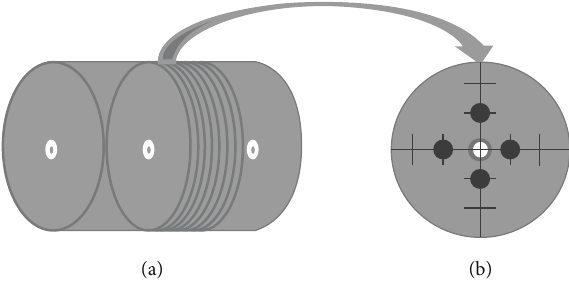
Figure 1: Stick drawing demonstrating the section process of histological examinations: (a) 8 cross-sections were obtained per- pendicular to the AV bundle in the middle; (b) 4 microphotographs of interest in the inner 1/3 radius at 3, 6, 9, and 12 o’clock at 400x magnification were evaluated for MVD (dark black points)